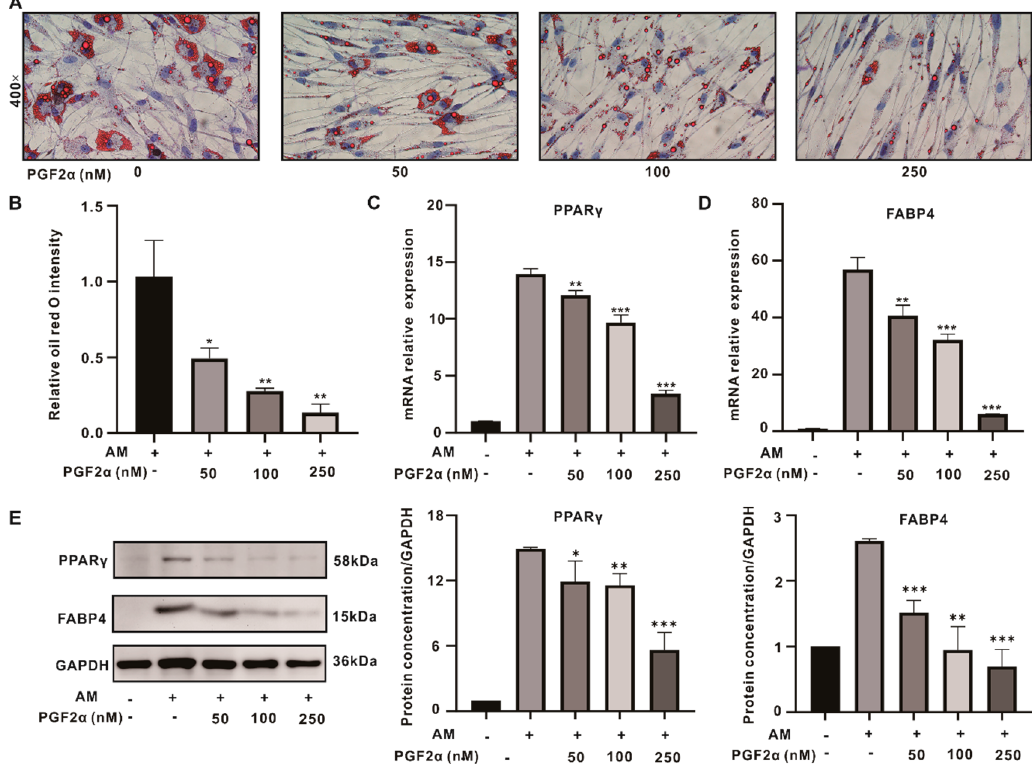
Figure 3. PGF2 α exerts anti − adipogenic effects on GO OFs. ( A ) Oil red O staining after treatment with different concentrations of PGF2 α . ( B ) The quantitative data from ( A ). ( C , D ) The mRNA levels of PPAR γ and FABP4 after treatment with different concentrations of PGF2 α . ( E ) The WB results for PPAR γ and FABP4 in each group; the protein levels were quantified and normalized to the level of GAPDH for each sample. Data are presented as the means ± SEMs ( n = 3) (*, p -value < 0.05; **, p -value < 0.01; ***, p -value < 0.001). AM: adipogenesis induction medium.